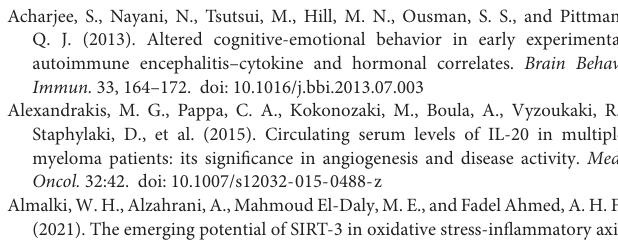
Supplementary Figure 6 | Cerebellar cytokine expression of wild-type mice and IL-20RB − / − mice at peak of EAE. Cytokines and VEGF expression within cerebellar tissues were detected by multianalyte bead-based immunoassay (A–M) and ELISA (N–P) , n = 4 (same cohort of mice shown on Figure 3 and Supplementary Figure 5 ), for wild-type mice at peak of EAE (peak, ∼ 14 dpi) (black circle) and sham-immunized, IL-20RB − / − mice (red circle), and sham-immunized (sham-immunized not shown). One-way ANOVA analysis followed by Sidak’s post hoc comparing wild-type mice and IL-20RB − / − mice at peak of EAE showed statistical significance only for GM-CSF, p < 0.05 (J) Results are shown as mean ± SEM, ∗ p < 0.05. Supplementary Figure 7 | Cytokine expression at the brainstem of wild-type mice and IL-20RB − / − mice at peak of EAE. Cytokines and VEGF expression within brainstem tissues were detected by multianalyte bead-based immunoassay (A–M) and ELISA (N–P) , n = 4 (same cohort of mice shown on Figure 3 and Supplementary Figure 5 ), for wild-type mice at peak of EAE (peak, ∼ 14 dpi) (black circle) and sham-immunized, IL-20RB − / − mice (red circle), and sham-immunized (sham-immunized not shown). One-way ANOVA analysis followed by Sidak’s post hoc comparing wild-type mice and IL-20RB − / − mice at peak of EAE showed statistical significance for GM-CSF, p < 0.01 (J) and TNF- α , p < 0.001 (L) . Results are shown as mean ± SEM, ∗ p < 0.05 and ∗∗∗ p < 0.001. Supplementary Figure 8 | Cytokine expression from serum of wild-type mice and IL-20RB − / − mice at peak of EAE. Serum cytokines and VEGF levels were detected by multianalyte bead-based immunoassay (A-M), n = 4 (same cohort of mice shown on Figure 3 and Supplementary Figure 5 ), for wild-type mice at peak of EAE (peak, ∼ 14 dpi) (black circle) and sham-immunized, IL-20RB − / − mice (red circle), and sham-immunized (sham-immunized not shown). Data was analyzed by one-way ANOVA analysis followed by Sidak’s post hoc and changes were not deemed significant. Results are shown as mean ± SEM. Supplementary Figure 9 | Murine expression of IL-20 receptor subunits. Murine microvessels were isolated from naïve C57BL/6J mice, n = 3, to elucidate IL-20 receptor subunits protein expression by immunolabeling for IL-22RA1 (white), IL-20RB (red), IL-20RA (green), and DAPI (blue), scale bar = 10 µ m (A) . Histogram analysis was performed to 25 microvessels per specimen to determine AUI and AUC of each receptor subunit (representative AUI vs. axis plot histogram, B ). Although AUC means exhibit a trend IL-22RA1 > IL-20RB > IL-20RA, one-way ANOVA analysis followed by Sidak’s post hoc test showed that mean AUC differences between subunits are not statistically significant (mean ± SD IL-22RA1: 6.2 × 10 − 4 ± 2.2 × 10 − 4 , IL-20RB: 4.2 × 10 − 4 ± 1.7 × 10 − 4 ,